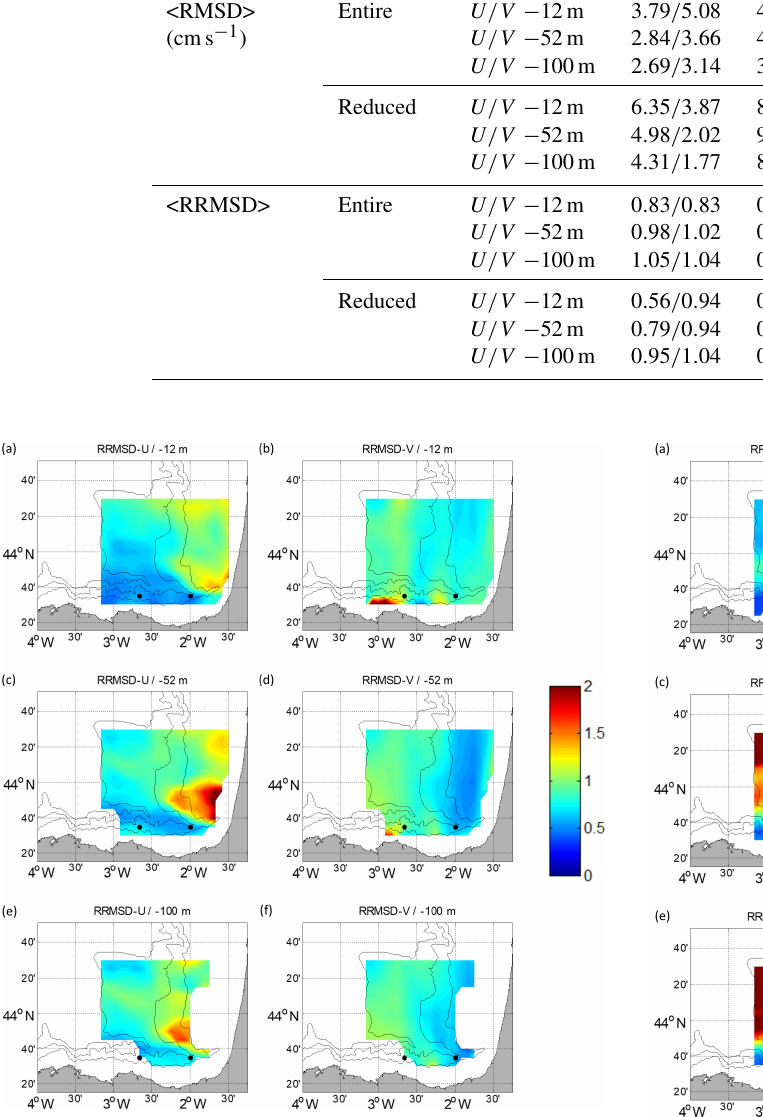
Figure 7. RRMSD maps for the winter period between the reference fields and the outputs of the ROOI with GLORYS-LR for U (a, c, e) and V (b, d, f) . Different depths are considered: − 12m (a, b) , − 52m (c, d) and − 100m (e, f) . The black dots depict the locations of the current vertical profiles.